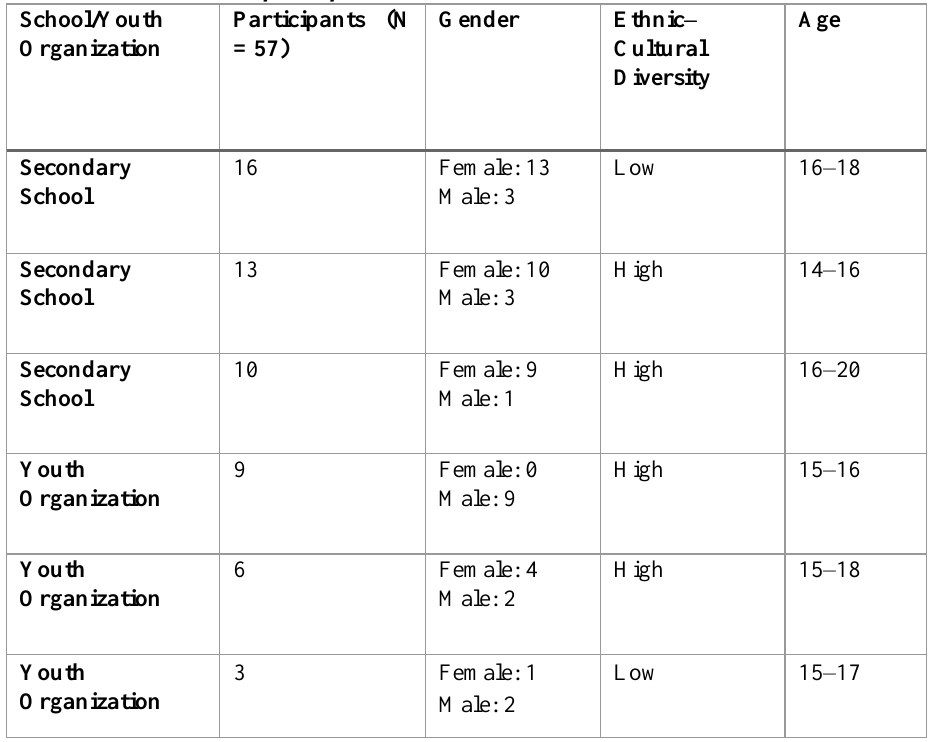
Table 1: Overview of the participants